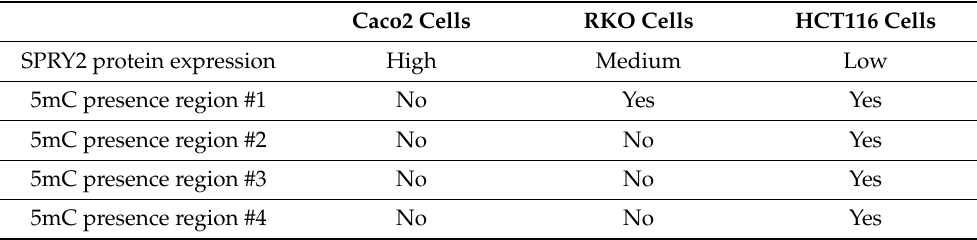
Table 1. Inverse correlation of SPRY2 regulatory 5mC and protein expression in CRC cell